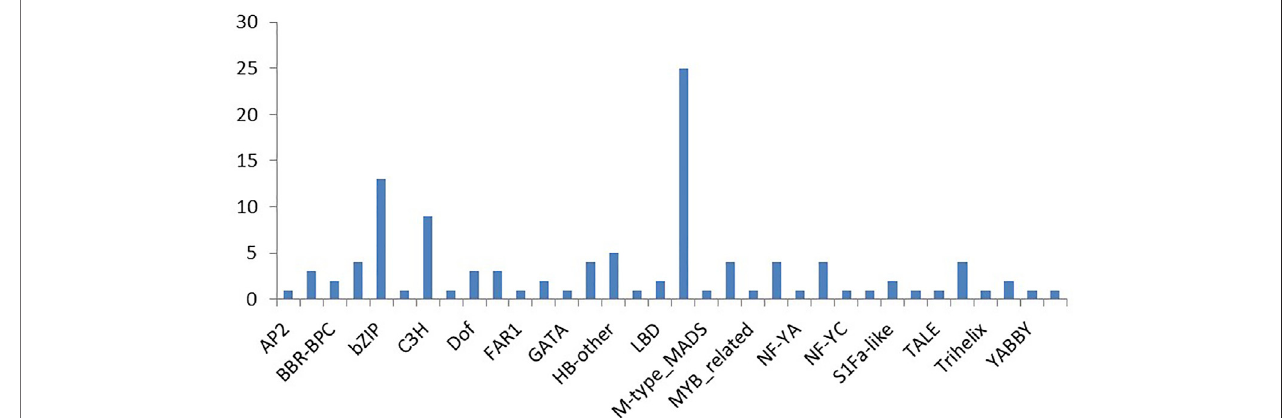
FIGURE 6 | Major transcription factor classes identi fi ed from cluster bean ESTs.